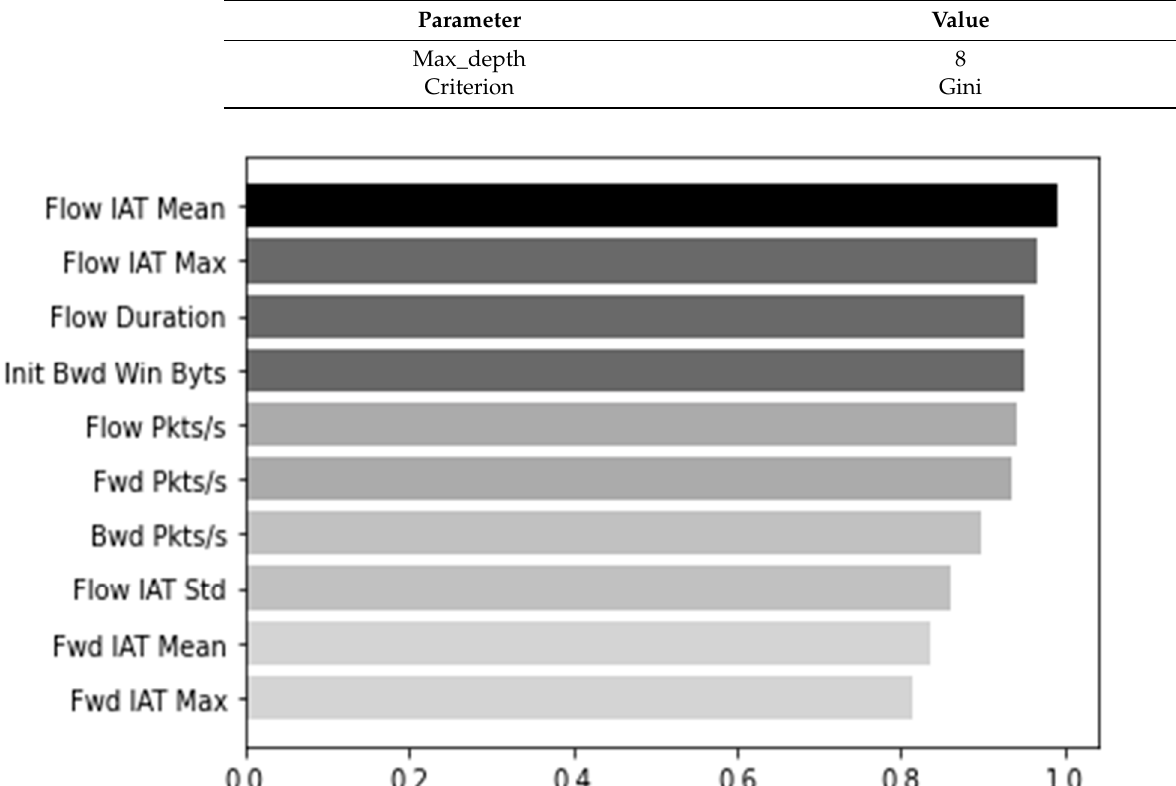
5 Table 5. XGBoost Model Confusion Matrix. Accuracy